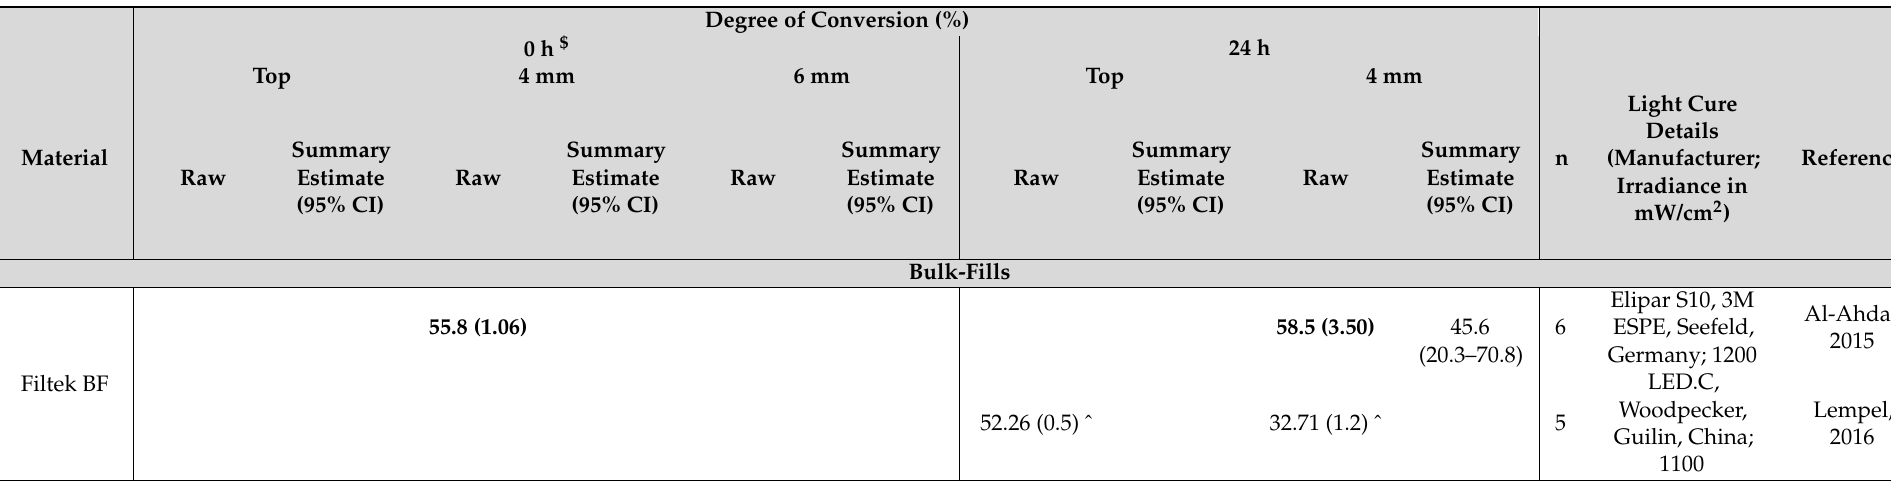
Table 5. Means and standard deviations (in parenthesis) of degree of conversion data from studies utilizing 20 s light curing protocol at 4 and 6